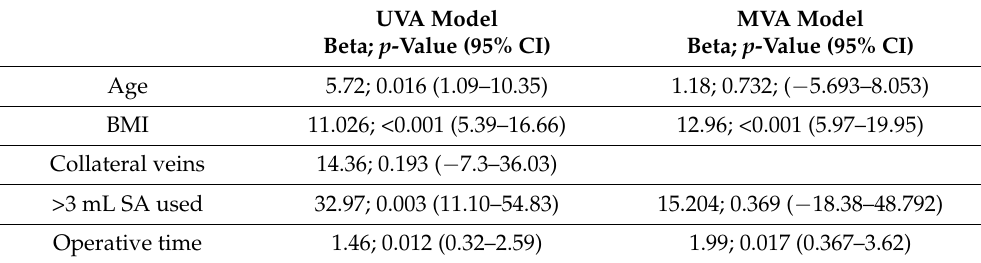
Table 3. Linear regression models predicting radiation exposure in the whole cohort (No. =